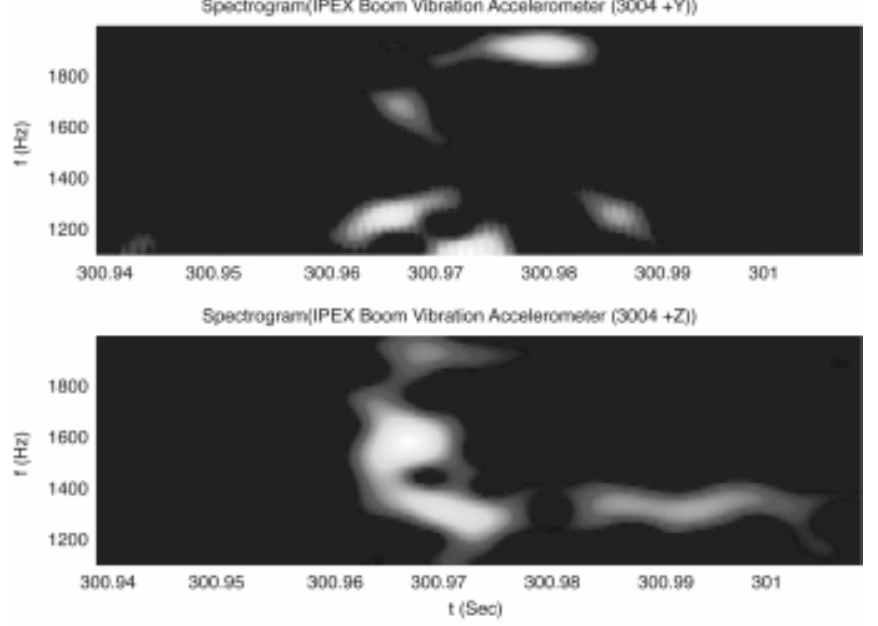
Fig. A8. Event 2 Node 3004 Spectrogram.